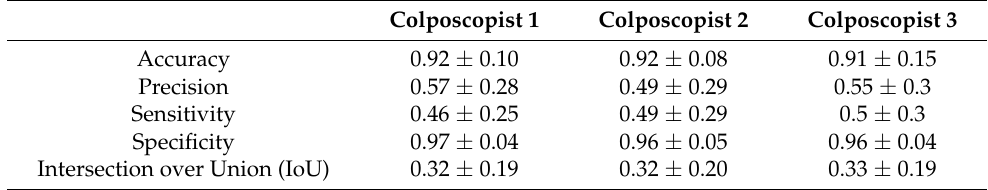
Table 4. Results when comparing predicted lesions by the algorithm and visual inspection with acetic acid (VIA) annotations by